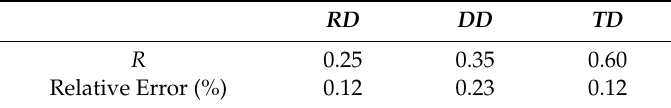
Table 4. Numerical Lankford coefficients ( 𝑅 ) and their relative errors.